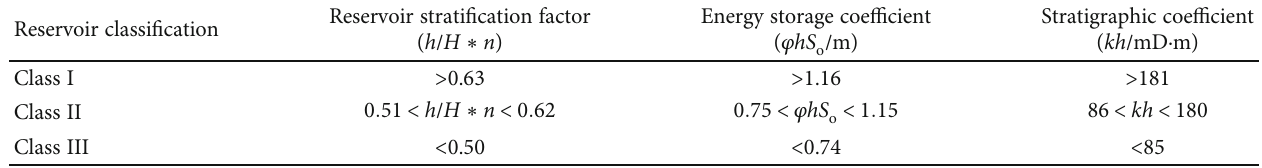
Table 2: Classi fi cation criteria for reservoir “ sweet spot ” indicators.